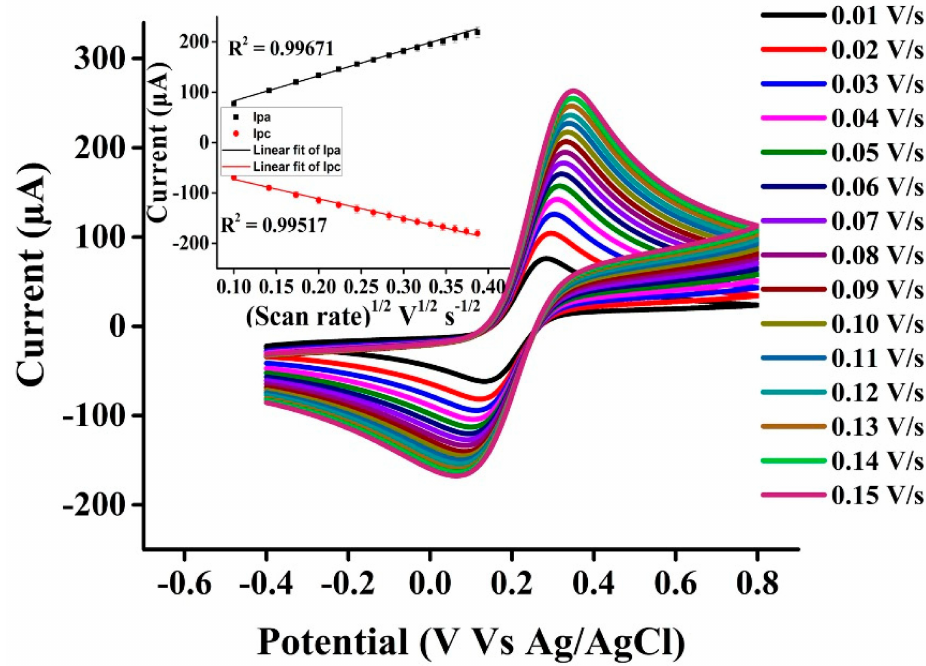
Figure 2. Plot depicting the scan rate range of 0.01 Vs − 1 to 0.15 Vs − 1 . The inset depicts the linear curve between the square root of the scan rate and the